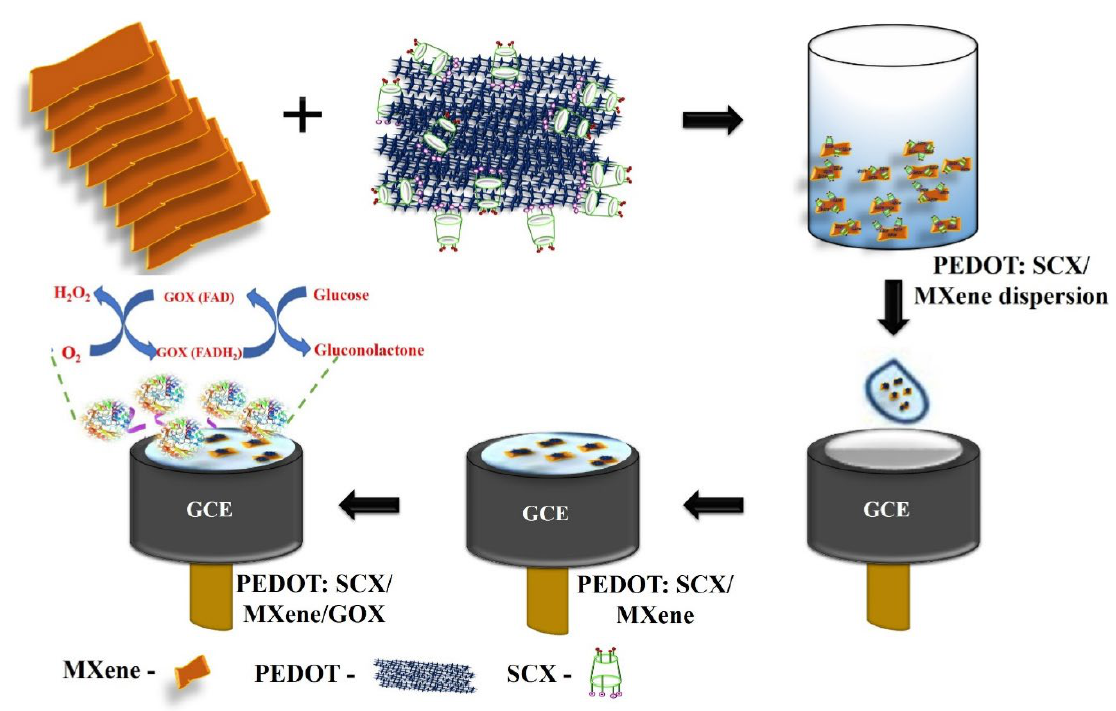
Figure 5. Synthesis of TMX/PEDOT/SCX and stepwise fabrication of glucose biosensor. Reproduced with permission from [103].